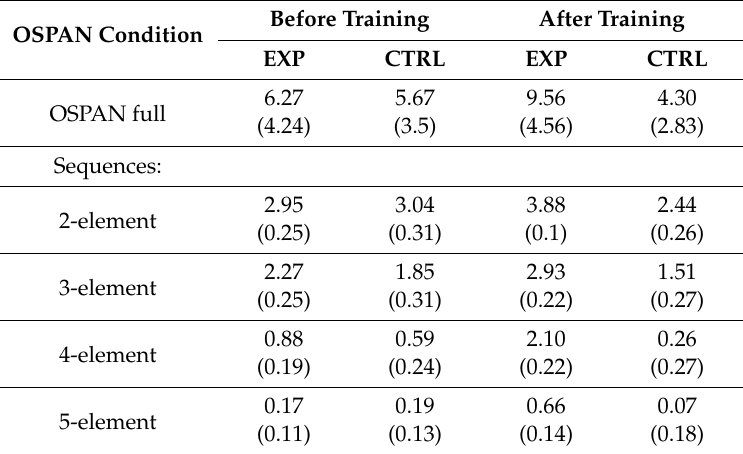
Table 2. Mean raw scores obtained in the OSPAN task for each level of difficulty by two groups (experimental and control) at two testing points (before and after training). Standard deviations are presented in